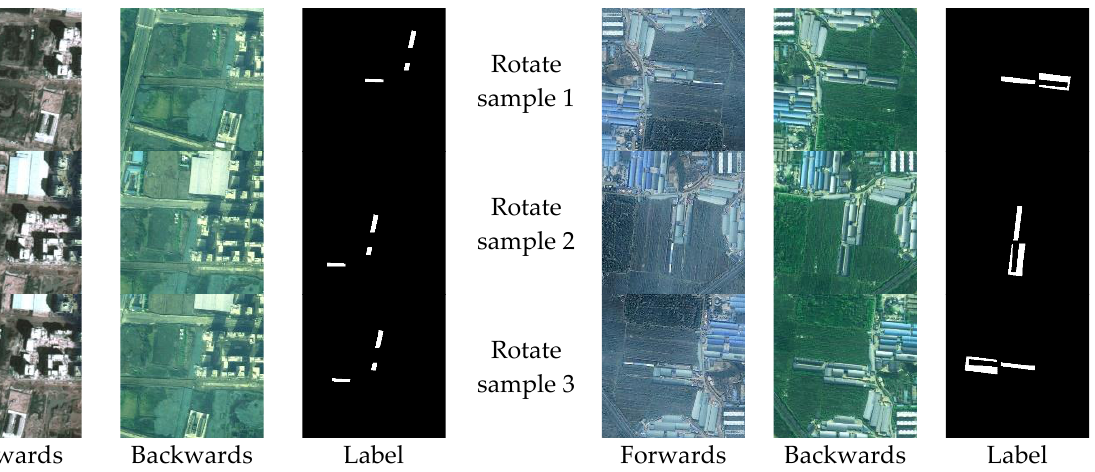
Figure 4. Newly expanded training dataset for construction.